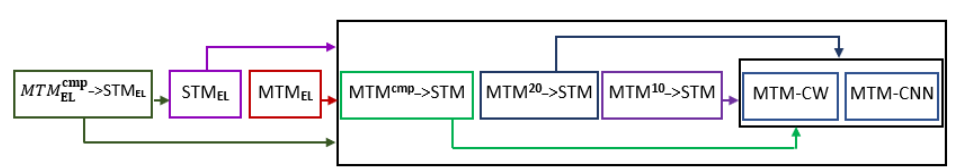
Figure 14. Graphical representation of the Friedman test ranks of ELMo. Models are shown according to their ranks starting with the best model from left to